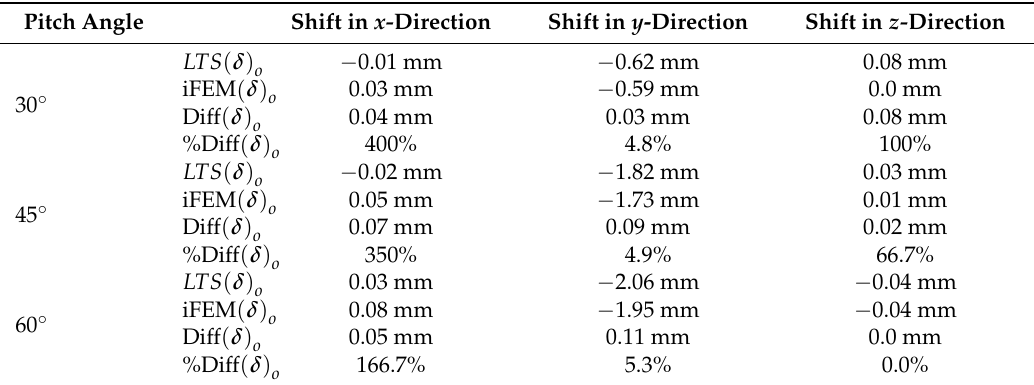
Table 3. The shifts measured using API Tracker 3 and the shifts computed from the strain data using the inverse Finite Element Method (iFEM).